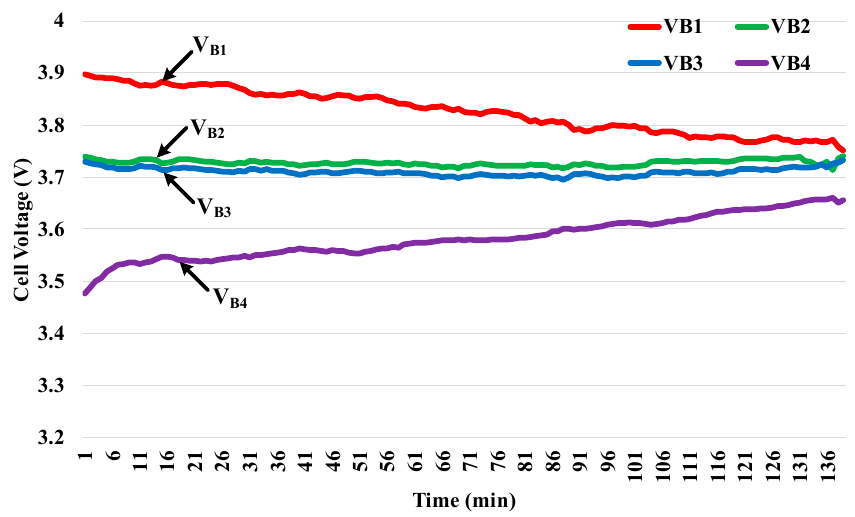
Figure 19. Voltage balance curve operated by the AVDC method.